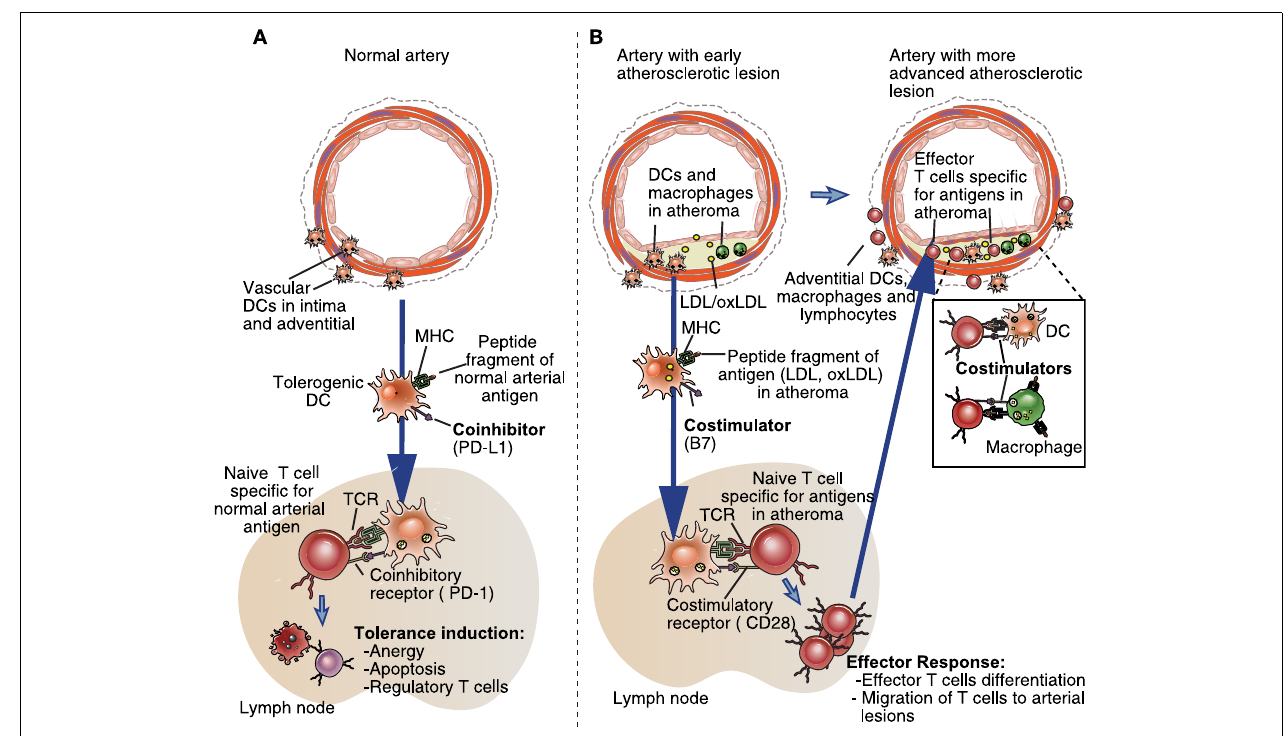
generation of protein antigens.These DCs could carry the antigens from the early atheromas to lymph nodes, and present them, in the form of peptide–MHC complexes, to naïveT cells specific for those antigens.The costimulators expressed on these mature DCs are required for productive naïveT cell activation and differentiation into effectorT cells.The effectorT cells then migrate out of the lymphoid tissues, and some will home to the atherosclerotic lesion. Both macrophages and DCs in the lesion may process and present the same atheroma-antigens (e.g., ApoB100 derived peptides) to the effectorT cells and activate theT cells to perform inflammatory effector functions that promote arterial disease. Costimulators present on the DCs and macrophages may enhance the effectorT cell responses. Note that CD4 + T cell responses are depicted in the figure, but the same principals apply for CD8 + T cell responses. A similar pattern of lymphoid tissue-based, costimulator-dependent priming and arterial wall based effectorT cell responses is likely to be relevant to other vascular inflammatory diseases, as discussed in the